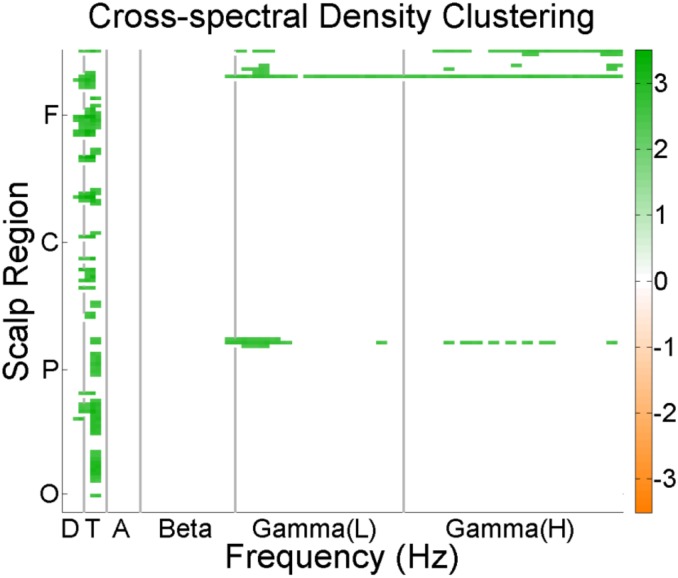
Scalp network connectivity.Shows difference in clustering coefficients between patients (green) and controls (orange) in different scalp regions. (F = Frontal, C = Central, P = Parietal O = Occipital) (D = Delta, T = Theta, A = Alpha L = Low, H = High).